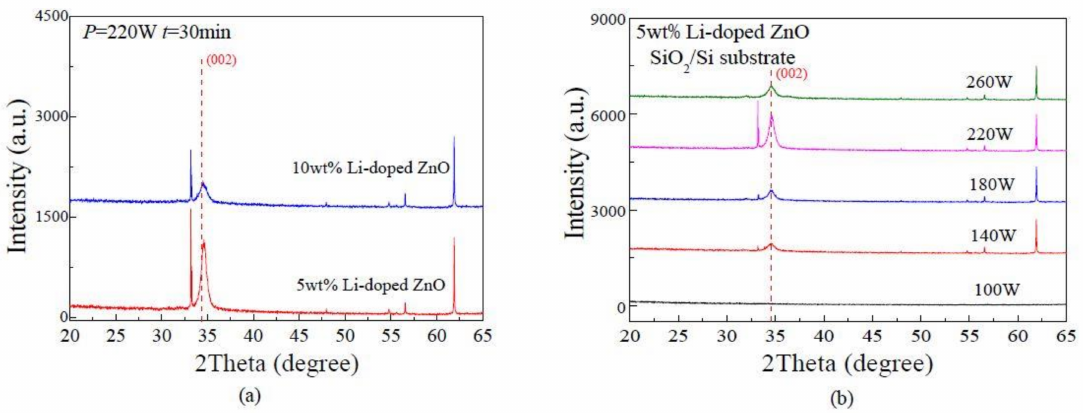
Figure 5. The X-ray diffractometer (XRD) patterns of the Li-doped ZnO thin films: ( a ) under different Li doping concentrations; ( b ) under different sputtering